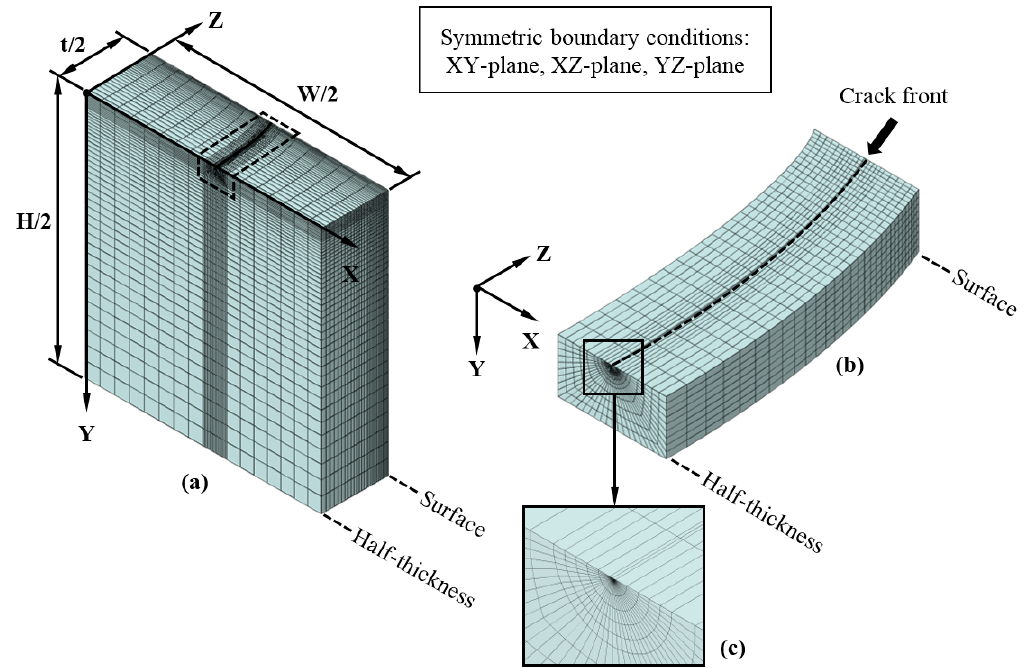
Figure 3. Finite element mesh: ( a ) assembled model; ( b ) detail of the crack front; ( c ) detail of the spider web pattern.